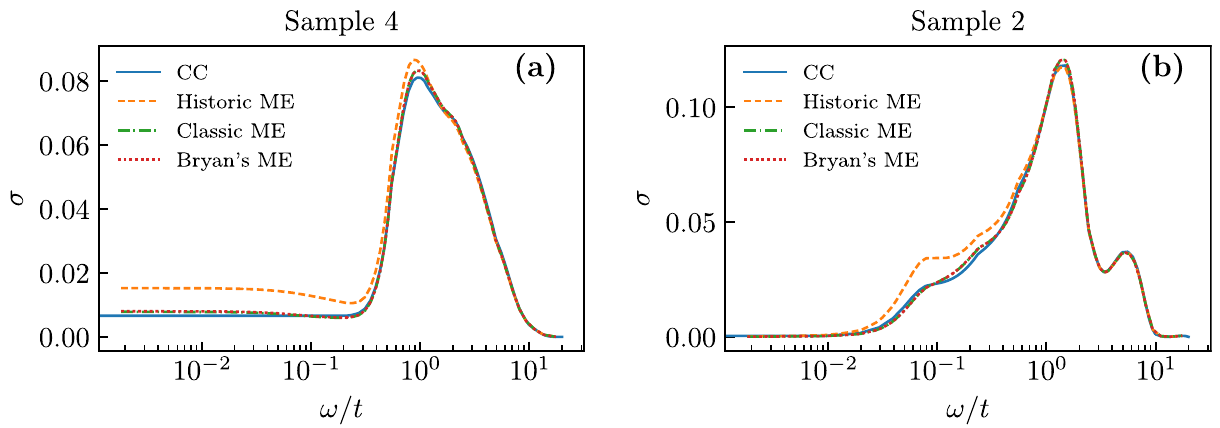
Fig. 6 Comparison of different analytic continuation algorithms for individual disorder realizations. Optical conductivity σ ( ω ) in a system with L = 64, β = 64, and W = 6. Panels a and b correspond each to a different disorder realization. Different lines correspond to different algorithms including, consistent constraints (solid blue), and three different maxent variants: historic (dashed yellow), classic (dash-dotted green), and Bryan ’ s method (dotted red) [see ref. 41 ].